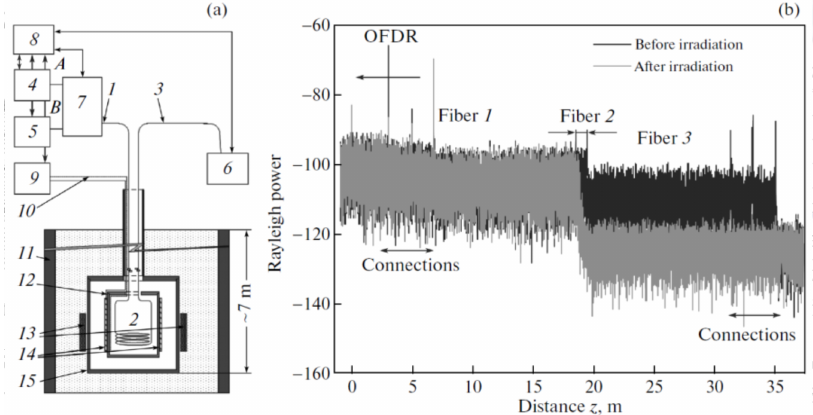
Figure 31. ( a ) Design of the experimental setup. (1–3) is Optical fibers, Fiber 1 and 3 are standard SMF. Fiber 2 is radiation sensitive fiber. (4) OFDR. (5) Superluminescent source. (6) Spectrum analyzer. (7) Fiber switch. (8) Computer. (9) Temperature controller. (10) Thermocouple element. (11) Water tank. (12) Furnace (13) 60 Co sources. (14) Heating elements. (15) Irradiation container. ( b ) Rayleigh backscattering trace before (black curve) and after (gray curve) irradiation (reprinted from Faustov et al. [69]. with permission of Springer Nature; copyright